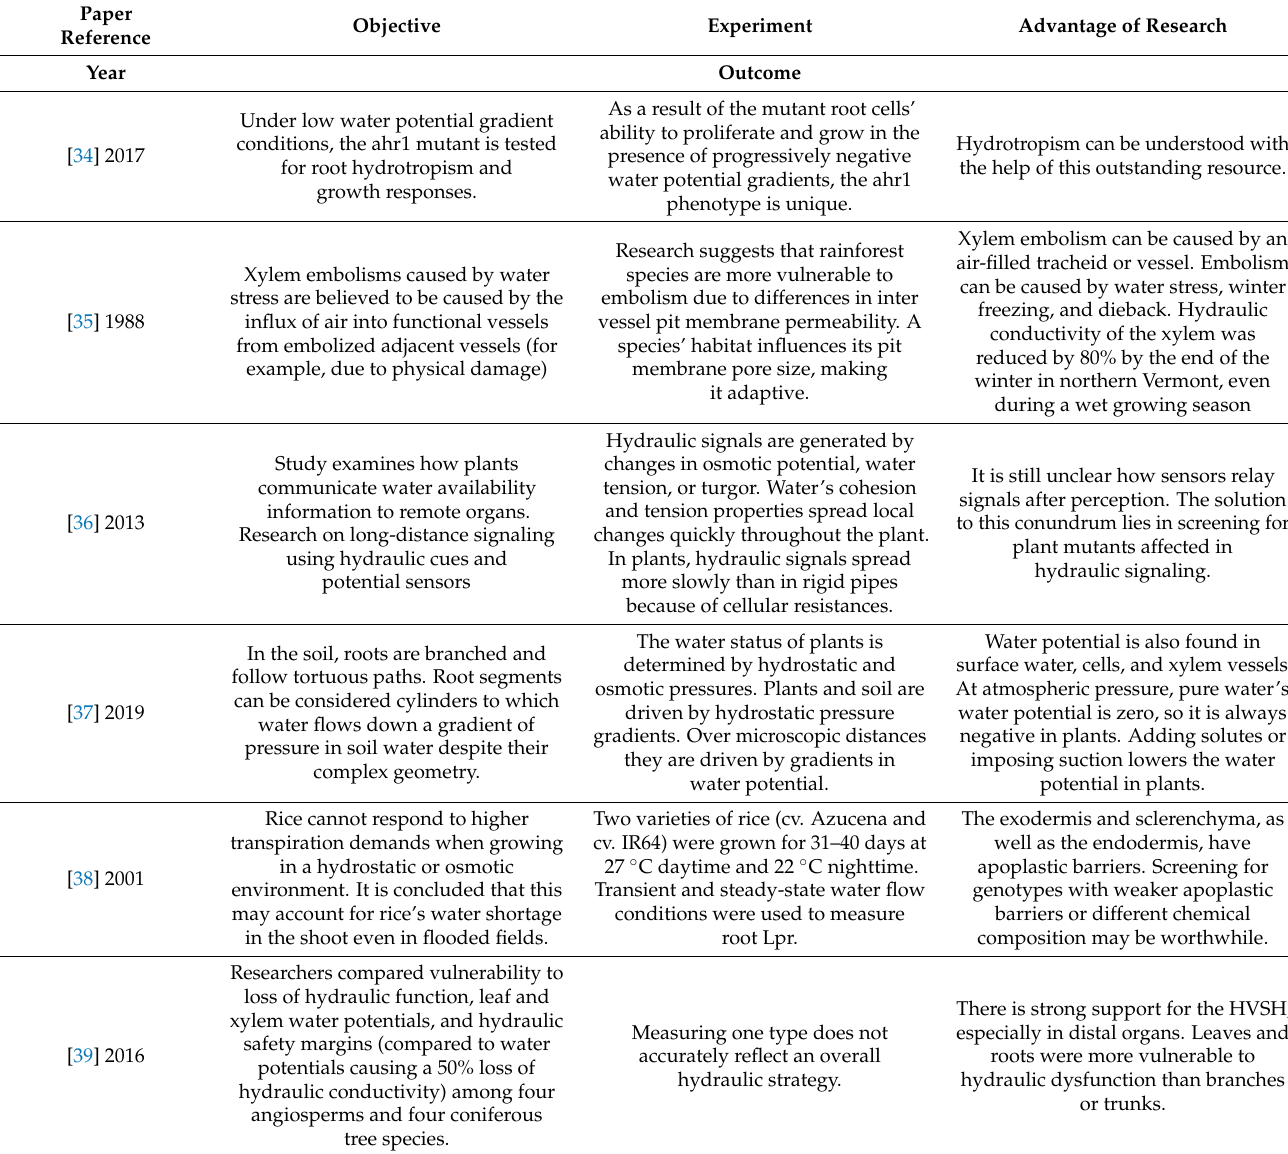
Table 1. An overview of recent research on the effects of hydrotropism stimulation on